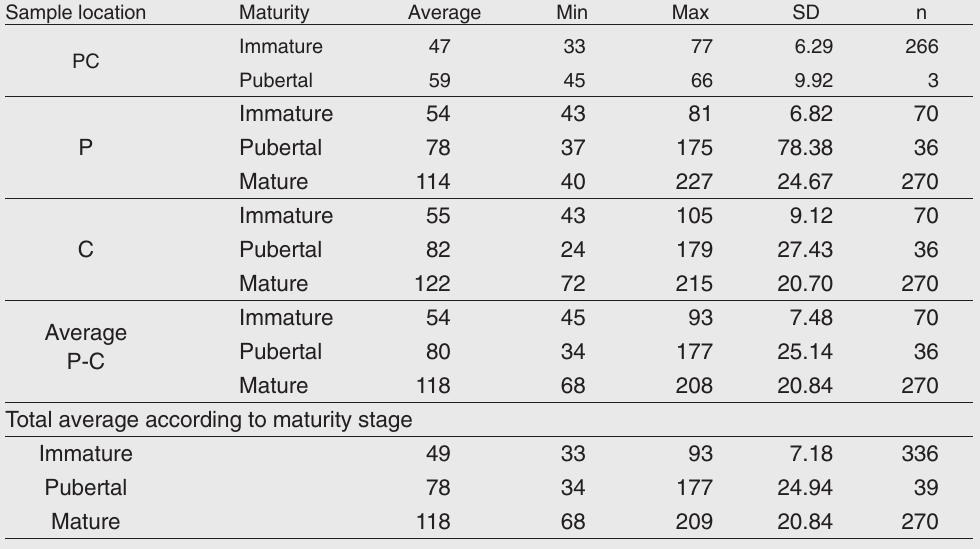
Table 2. Summary statistics for seminiferous tubule diameter (µm) grouped by sample loca- tion (PC = combined peripheral and central, P = peripheral, C = central) and maturity stage and total average tubule diameter (µm) according to maturity